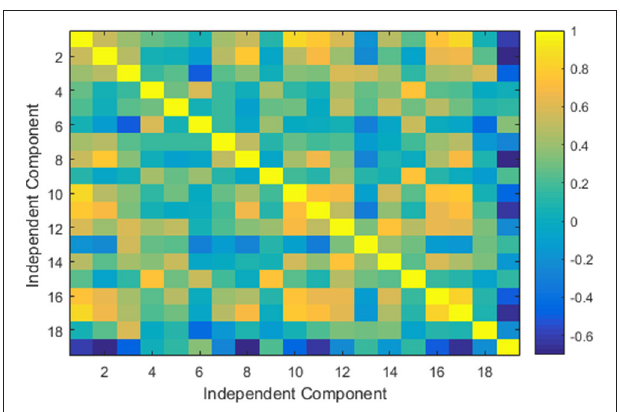
FIGURE 3 | An example of a typical group independent component analysis based connectivity matrix for one of the control subject of COBRE dataset.